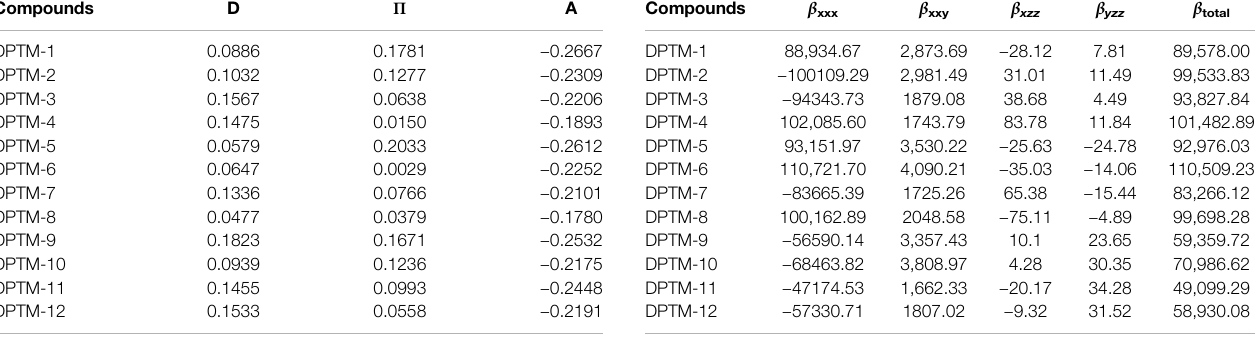
TABLE 3 | NBO charges for donor, π -linkers, and acceptor of the investigated compounds (DPTM-1 to DPTM-12). Compounds